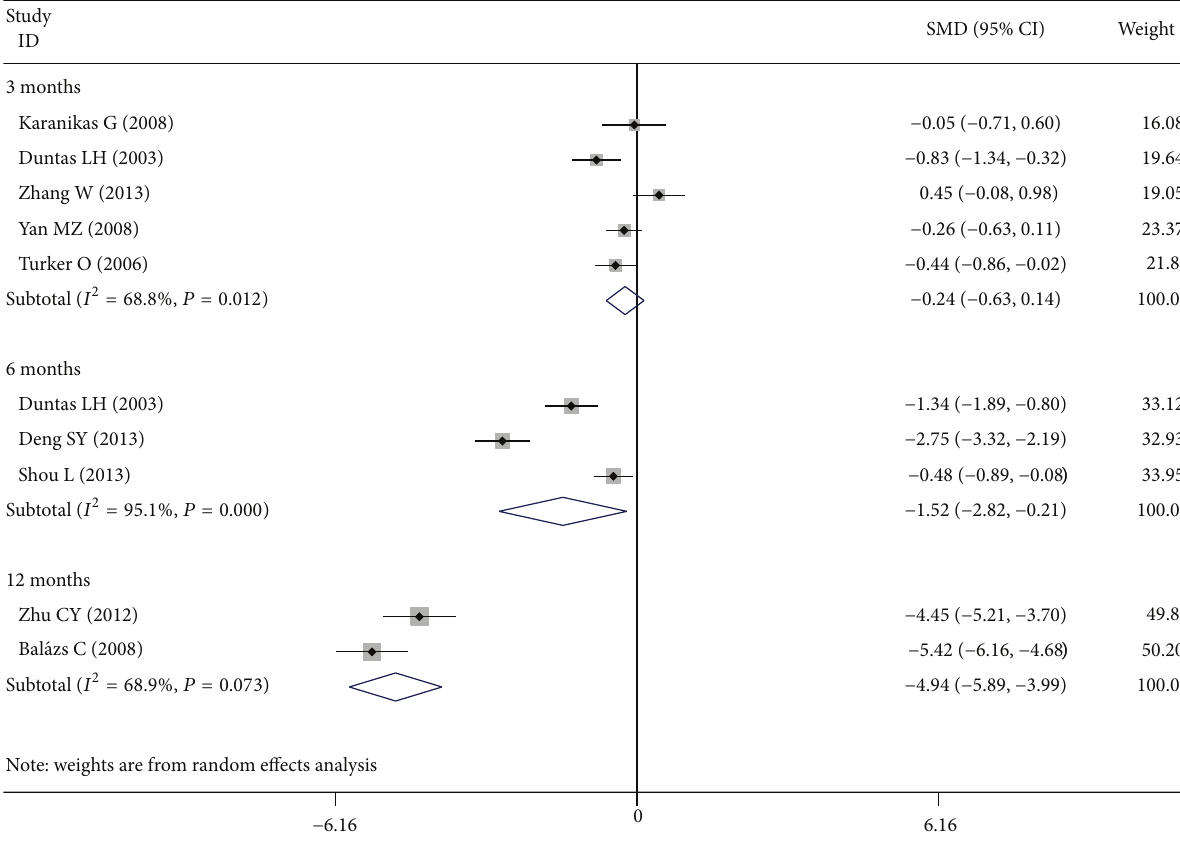
2 to 4 points out of a theoretical maximum of 5 points.